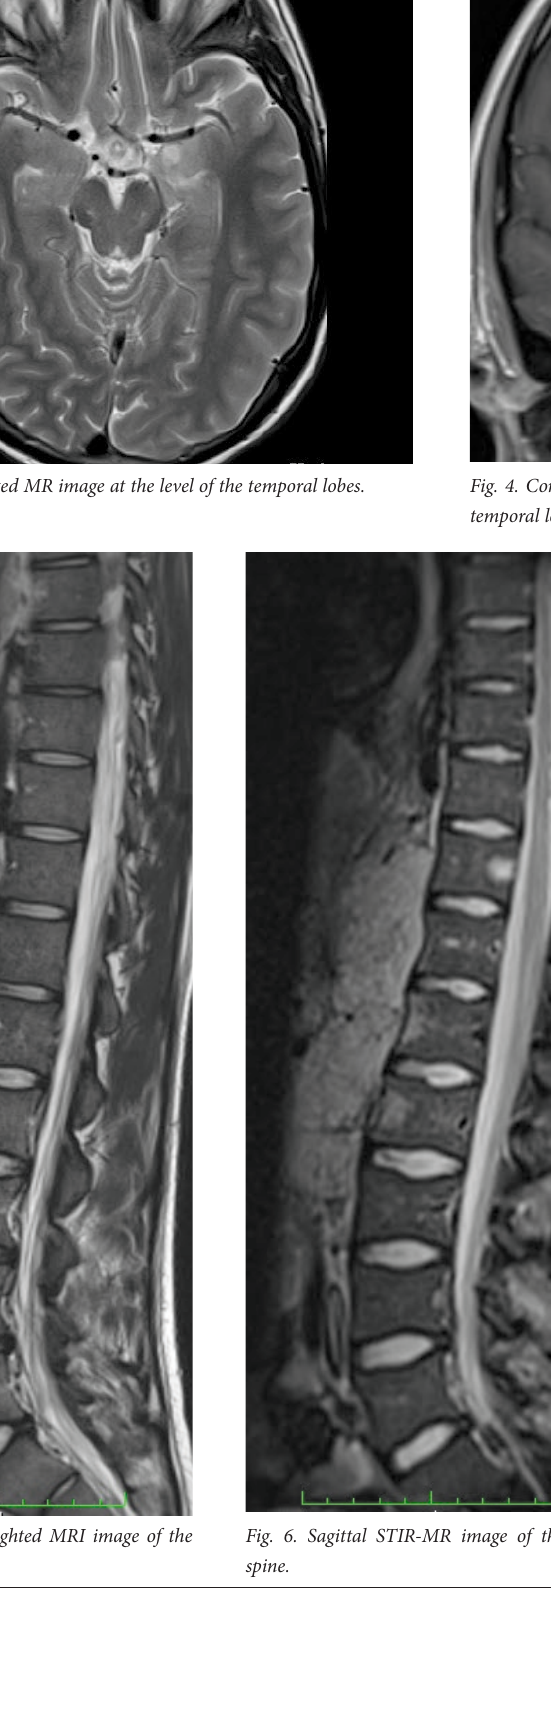
SAJR June 2013 Vol. 17 No. 2 75